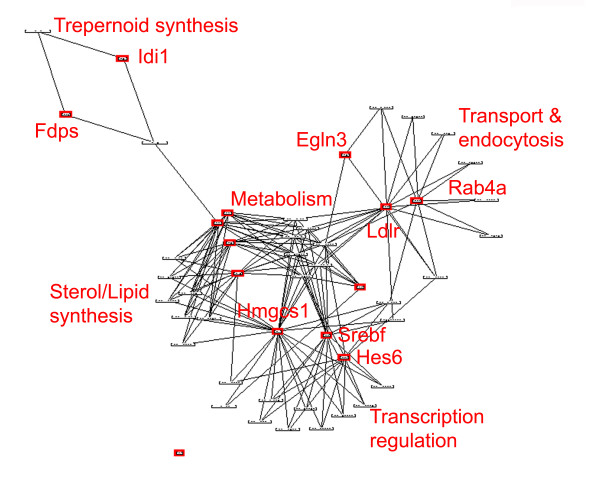
Manipulation and filtering of GTAN based on association degree. The GTAN from Fig. 9 was filtered to get rid of terms with minimal association of genes. Genes are highlighted in red. Terms tend to be shared by multiple genes and are labeled as summarized descriptions for simplicity purpose.